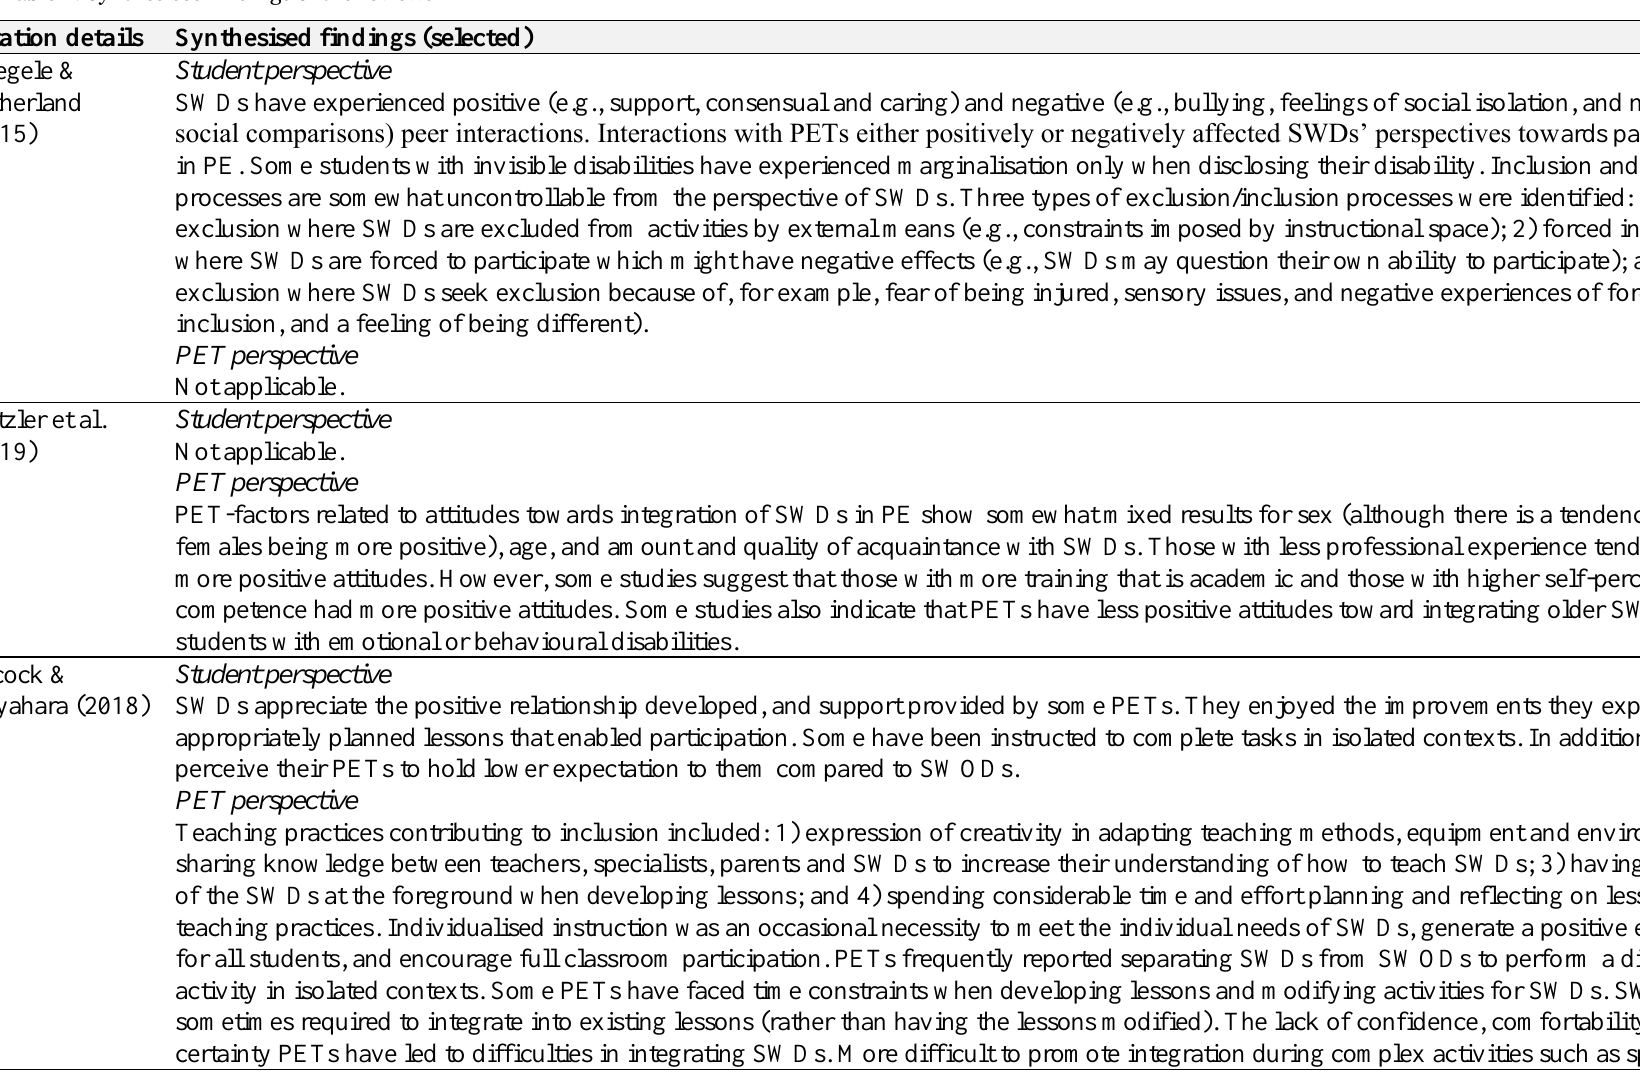
Table 2. Synthesised findings of the